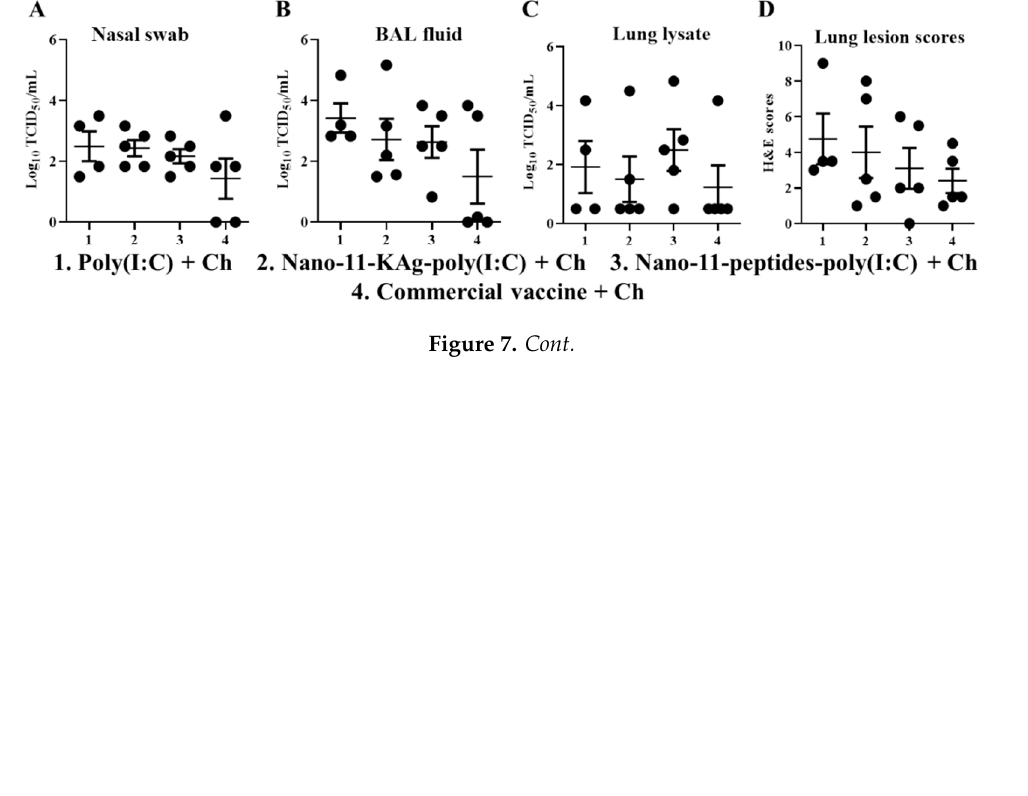
Figure 7. Nano-11 and commercial influenza vaccines reduced the challenge virus titer and virus induced lung pathology. Pigs were vaccinated twice with poly(I:C) adjuvanted Nano-11-based